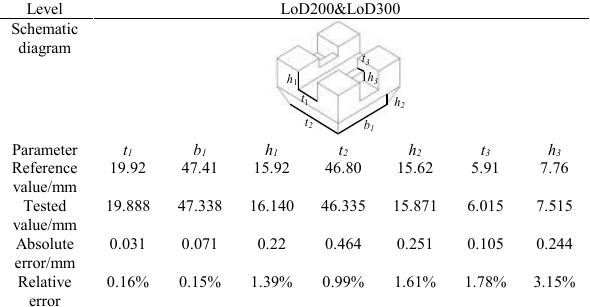
Table 4. Extraction results and accuracy of LoD200&LoD300 of Ludou.